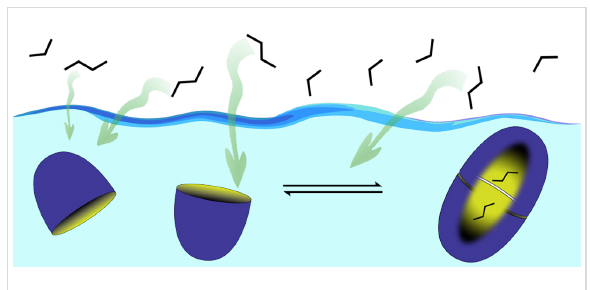
Figure 12: Schematic of the inter-phase separation of propane and butane; the latter binds more strongly to the capsule formed by octa- acid and so is selectively sequestered into aqueous solution.